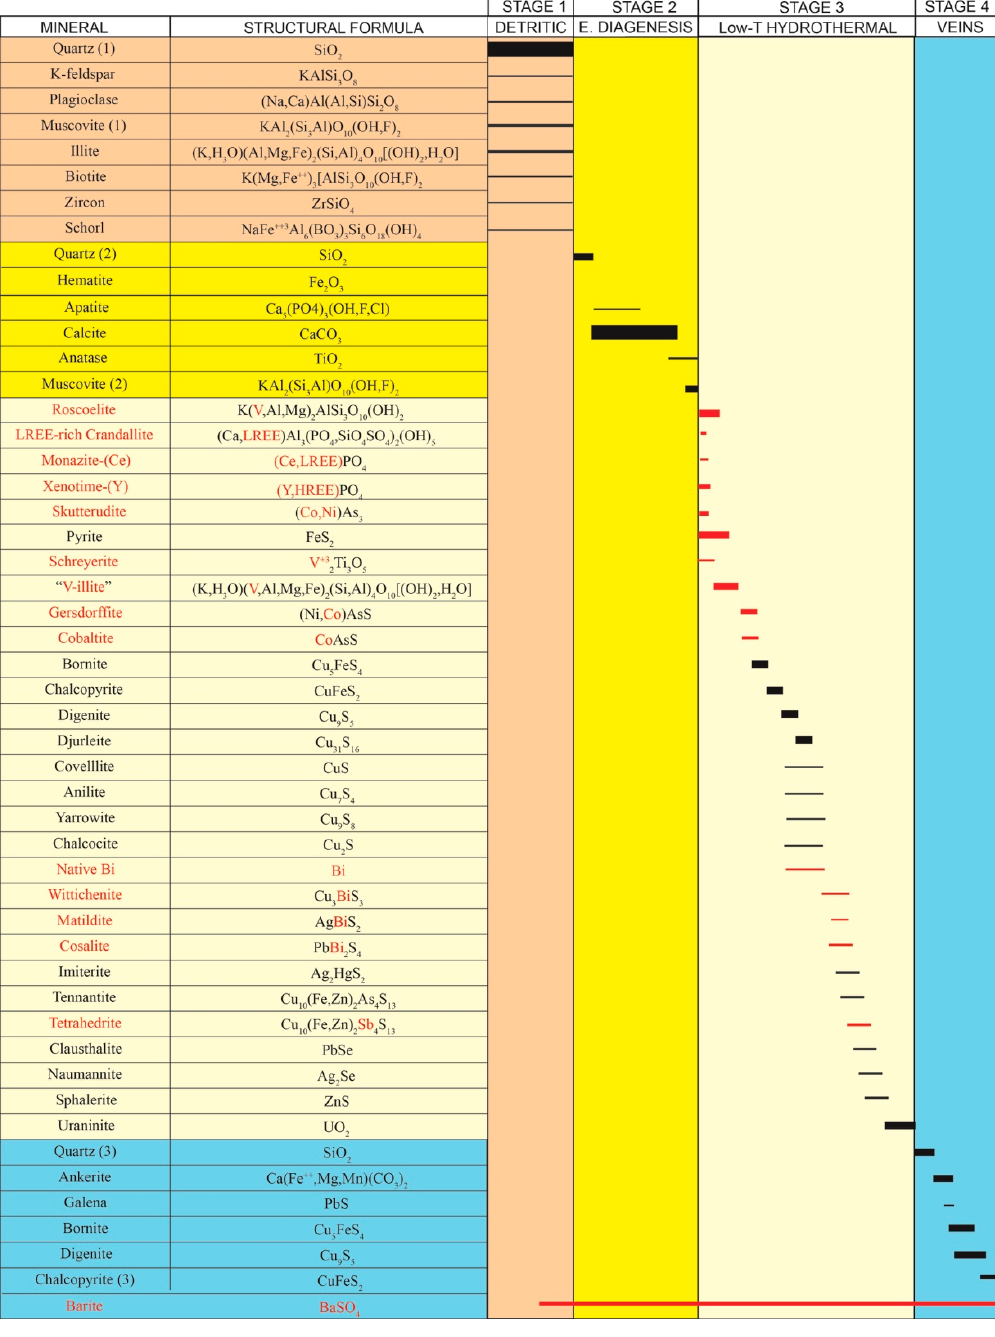
Figure 9. Crystallization sequence of the stratabound and vein mineralisation. Critical metals [22] and the minerals accommodating them are highlighted in red colour. Thickness of the bars indicates the relative abundance of the minerals.